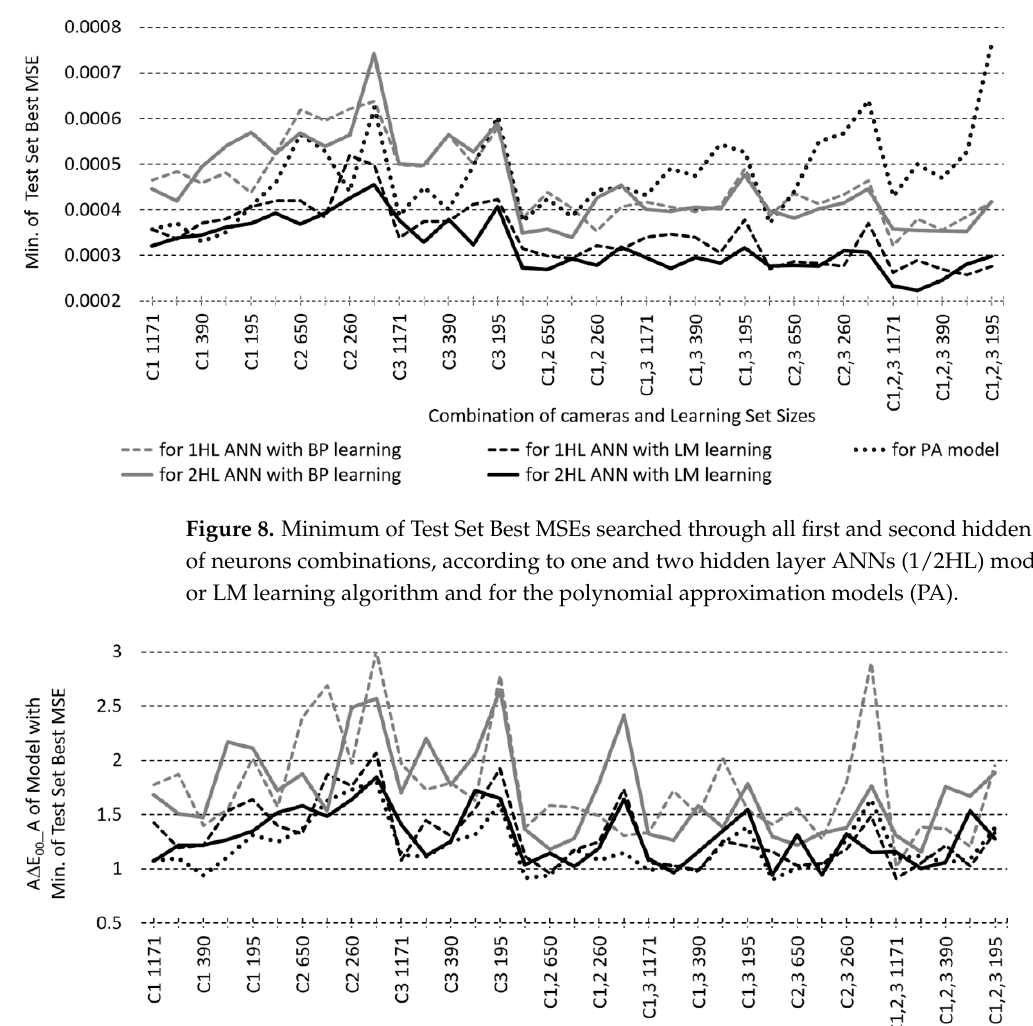
( c ) Figure 7. Examples of an in-number-of-cameras average best test set performances: ( a ) MSE for LS size of 650, ( b ) AGoFC for the largest LS size, and ( c ) A ∆ E* 00 (F2 illuminant) for the smallest LS size, according to the number of cameras. 4.5. Comparison of the Best Performances of ANN and PA Models. To find the best models, the sequence of comparisons of ANN and PA models’ best performances according to MSE, AGoFC, and A ∆ E* 00 (for all illuminants) was performed. The performances of ANN and PA models with the best test set MSE are compared below. For each combination of camera-combinations, LS size, and BP/LM learning algo- rithm, we have 46 models for 1HL ANN (for HL1 NoN from 3 to 48), for 2HL 256 models (for HL1 and HL2 from 3 to 48 in a step of 3), and for PA a different number of the models with the best MSE, according to the highest possible calculated degree of the polynomial. To compare the best test set MSE for each camera-combination/LS size/learning algo- rithm combination, first, the models with the smallest MSEs have been found: for 1HL and 2HL ANN by searching through all HL1/HL2 NoN combinations, and for PA models through all available degrees of polynomials. Then, the smallest MSEs for ANN and PA were compared for all camera-combination/LS size combinations (Figure 8). The compar-